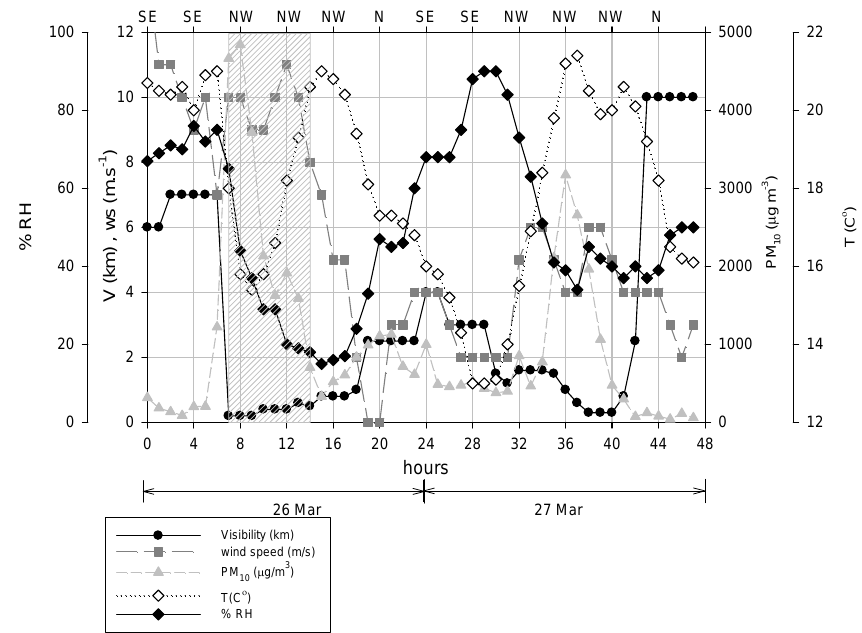
Fig. 7. Hourly variation of visibility, V (km), wind speed, WS (ms − 1 ), PM 10 (µgm − 3 ), temperature T ( ◦ C) and wind direction (top axis) for 26–27 March 2003. The shaded area represents dust storm hours at Kuwait local time ( +